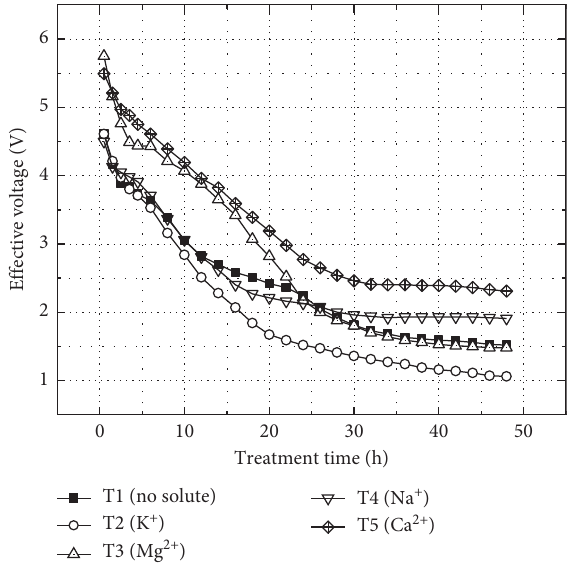
Figure 3: Volume of drainage variations over treatment time.